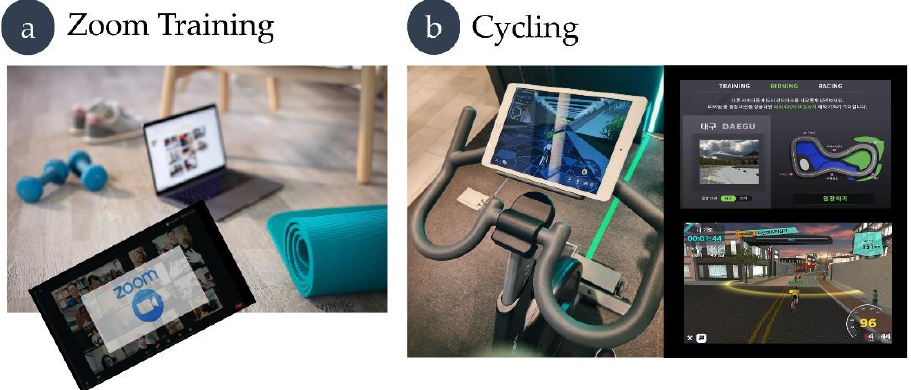
Figure 6. Practical physical education in the mirror world.